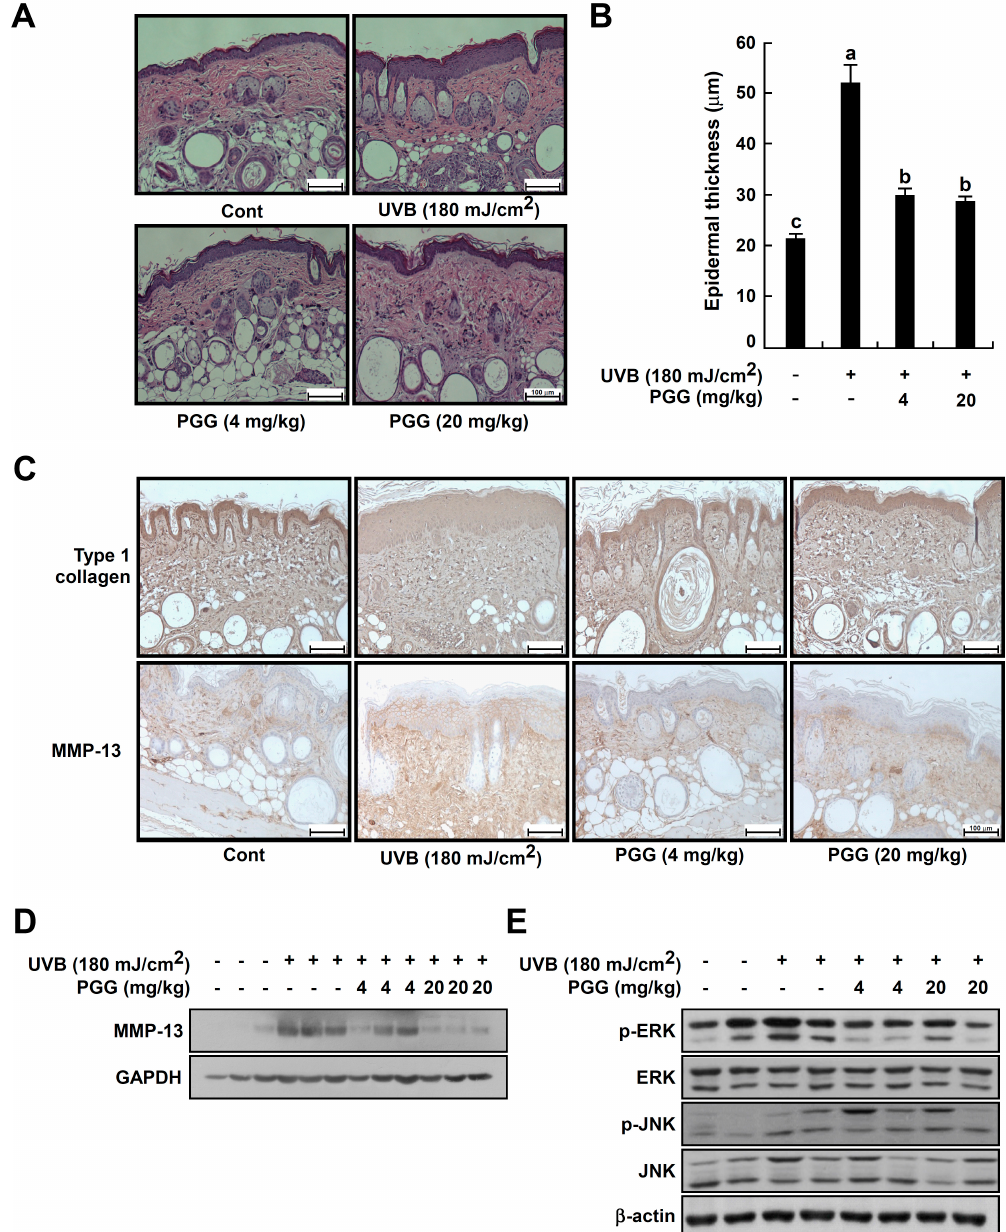
Figure 6. E ff ect of PGG on histological and molecular properties in mouse dorsal skin following UVB irradiation. ( A ) Histological evaluation by hematoxylin and eosin-staining of UVB-irradiated mouse skin. Images are representative of five tissue samples. ( B ) E ff ect of PGG on UVB-induced epidermal thickening. The epidermal thickness was measured using image in Figure 6A. Bars represent the mean thickness ( µ m) of the epidermis from five animals. Results are shown as the means ± standard error (S.E.) ( n = 5). Values that do not share common letter (a,b,c) on bar indicate statistically significant di ff erence from each other ( p < 0.05). ( C , D ) E ff ect of PGG on UVB-induced type 1 collagen degradation and MMP-13 expression on mouse dorsal skin. Immunohistochemstry and western blot analysis were performed as described in ’Materials and Methods’ using specific antibodies for each protein. ( E ) E ff ect of PGG on UVB-induced MAPK signaling pathway on mouse dorsal skin. Protein was extracted from mouse dorsal skin as described in ‘Materials and Methods’. Western blot analysis was performed to determine levels of phosphorylated and total ERK and JNK